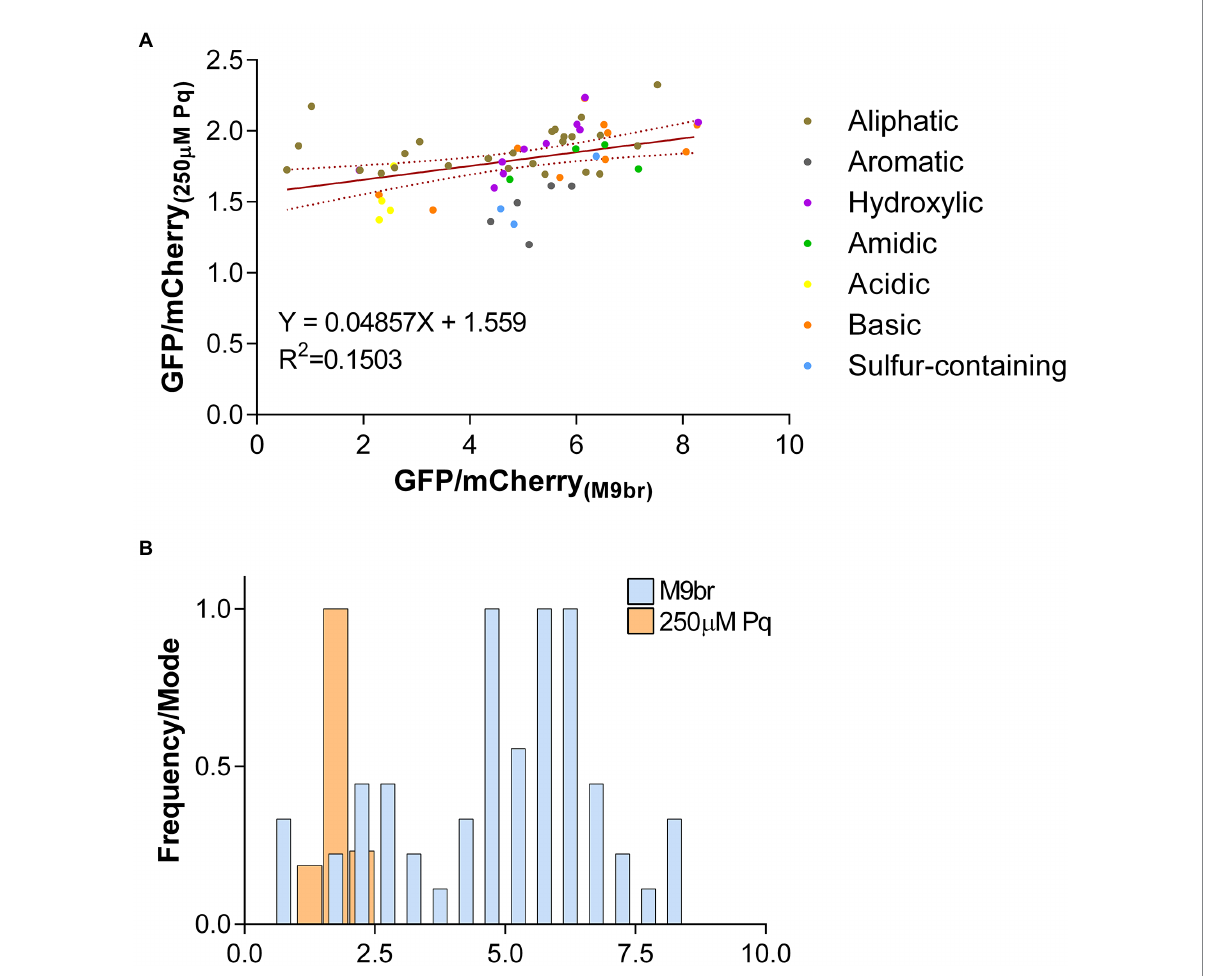
FIGURE 2 The effects of codon choice on the production of GFP are suppressed by oxidative stress. (A) The ratios between GFP and mCherry fluorescence for each reporter strain observed under oxidative stress conditions are plotted against the values observed under non-stress conditions. A linear tendency trend line is plotted in red with dotted lines representing the 95% confidence interval of the best-fit line (B) Histogram showing the number of reporters that present each GFP/mCherry fluorescence ratios under control and oxidative stress conditions. The total number of reporters in each range were normalized against the most frequent number for the condition (Frequency/Mode) so that the height of bars are similar for both conditions. Bins for both conditions are 0.5. Control bars are thinner to allow visualization of bars for the stress condition. Data presented in this figure is a different representation of data presented in Figure 1B and Supplementary Figure